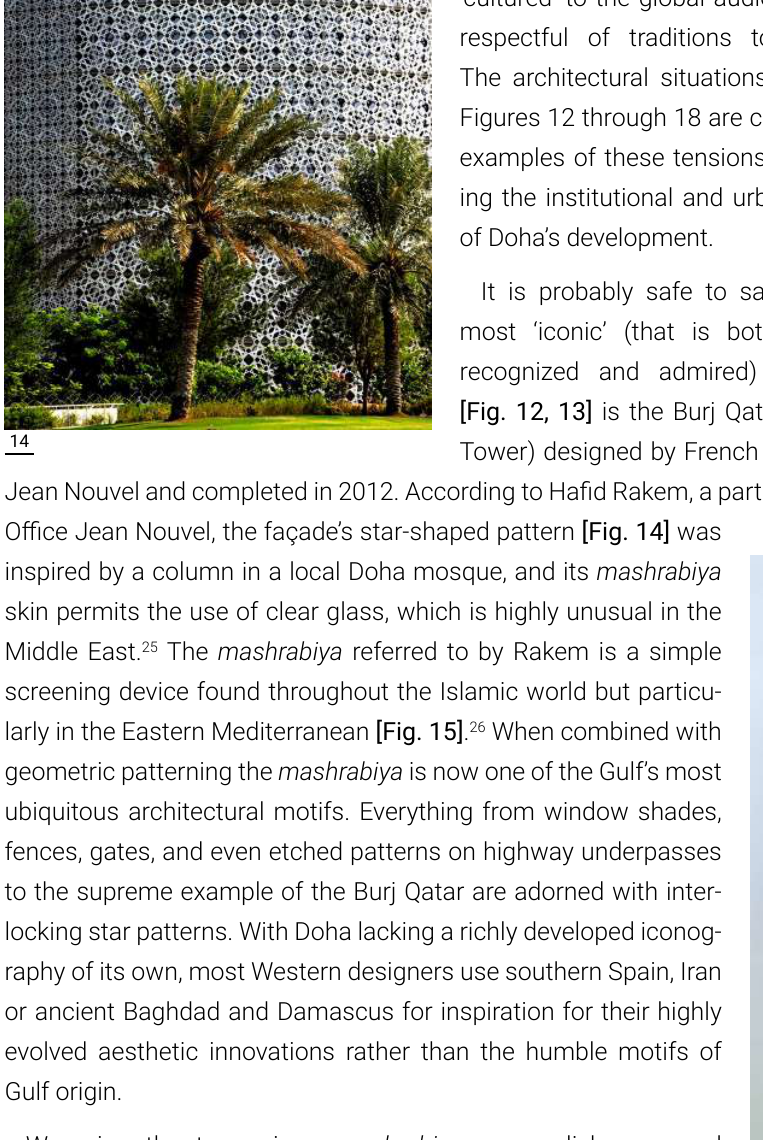
Example of an Egyptian mashrabiya from the Museum of Islamic Art, Cairo, Egypt (Source: Milad Moawad,